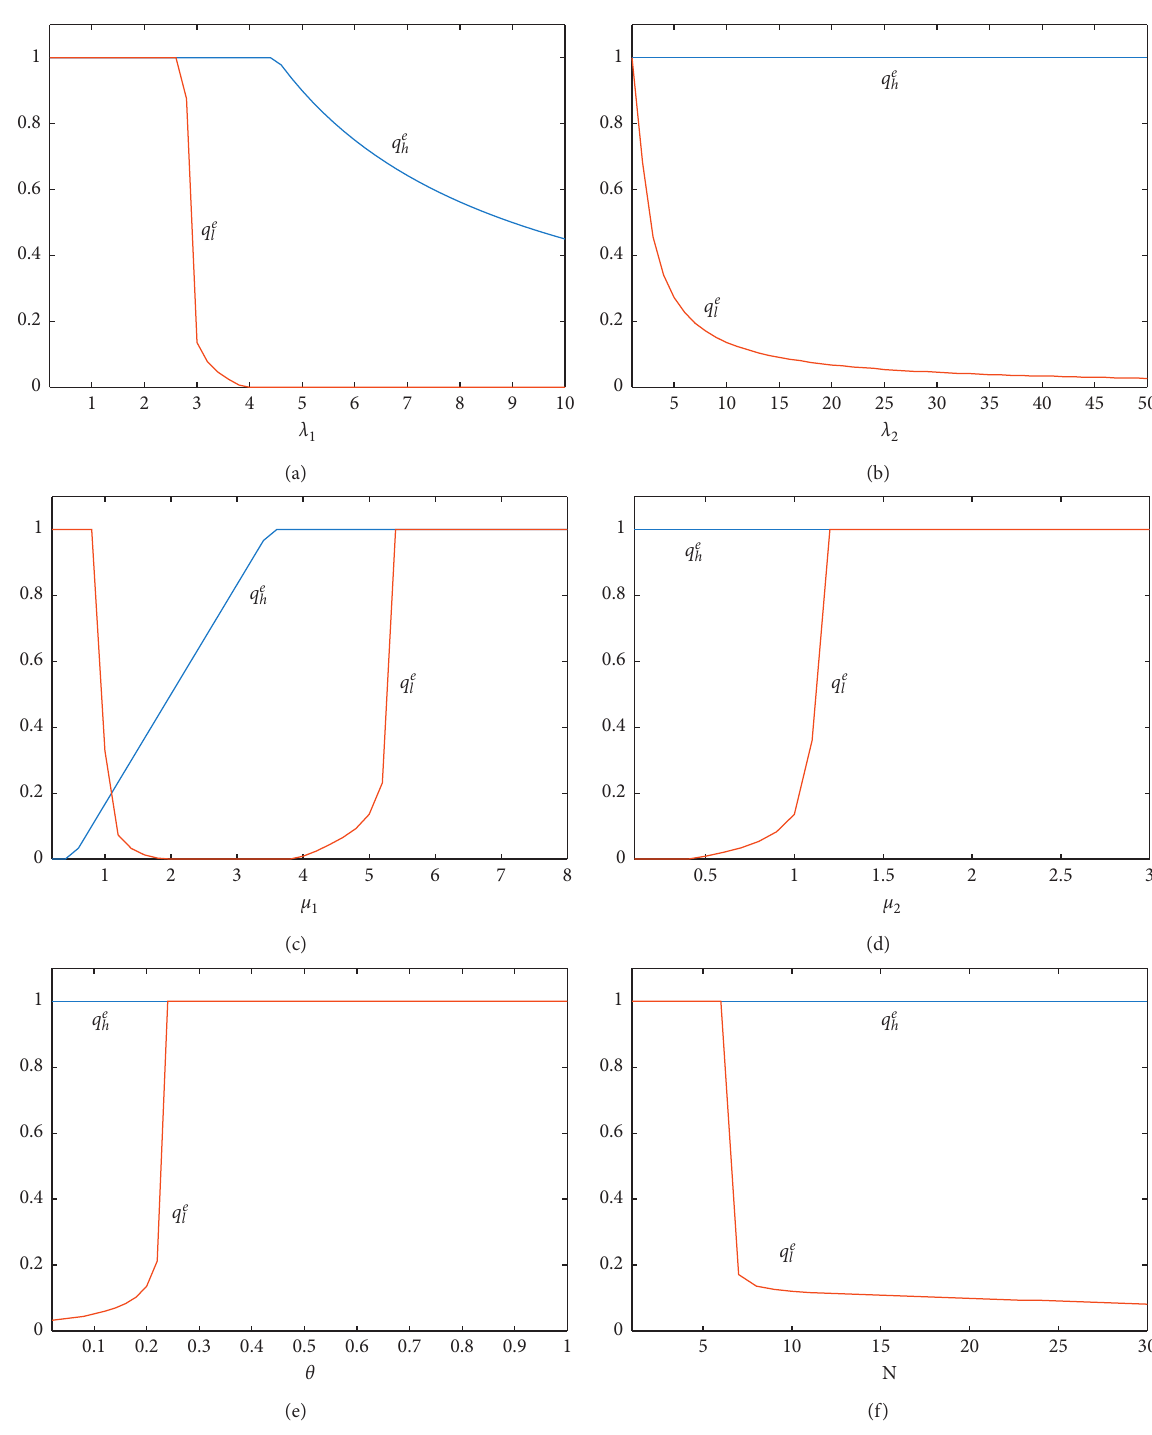
and q e h and q e h